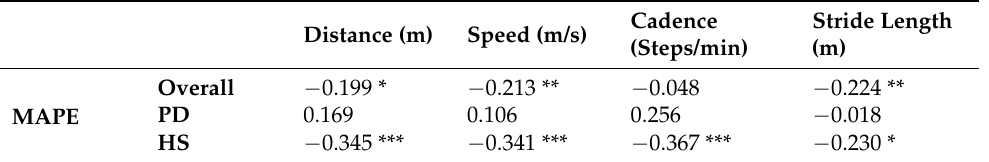
Table 4. Spearman rho correlation coefficient between spatiotemporal gait parameters and MAPE in the general population, PD patients, and healthy participants. Significant correlations are reported as follows: * p < 0.05; ** p < 0.01; *** p < 0.001. HS: Healthy subjects; MAPE: Mean absolute percentage error; PD: Parkinson’s disease. Cadence Distance (m) Speed (m/s) (Steps/min) Overall − 0.199 * − 0.213 MAPE